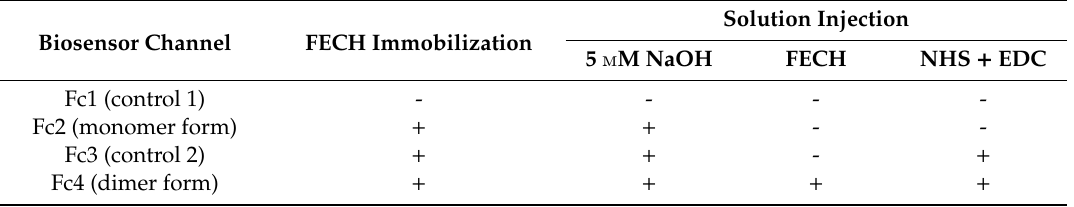
Table 4. Preparation of the model system “monomer-dimer” FECH on the chip of a four-channel SPR